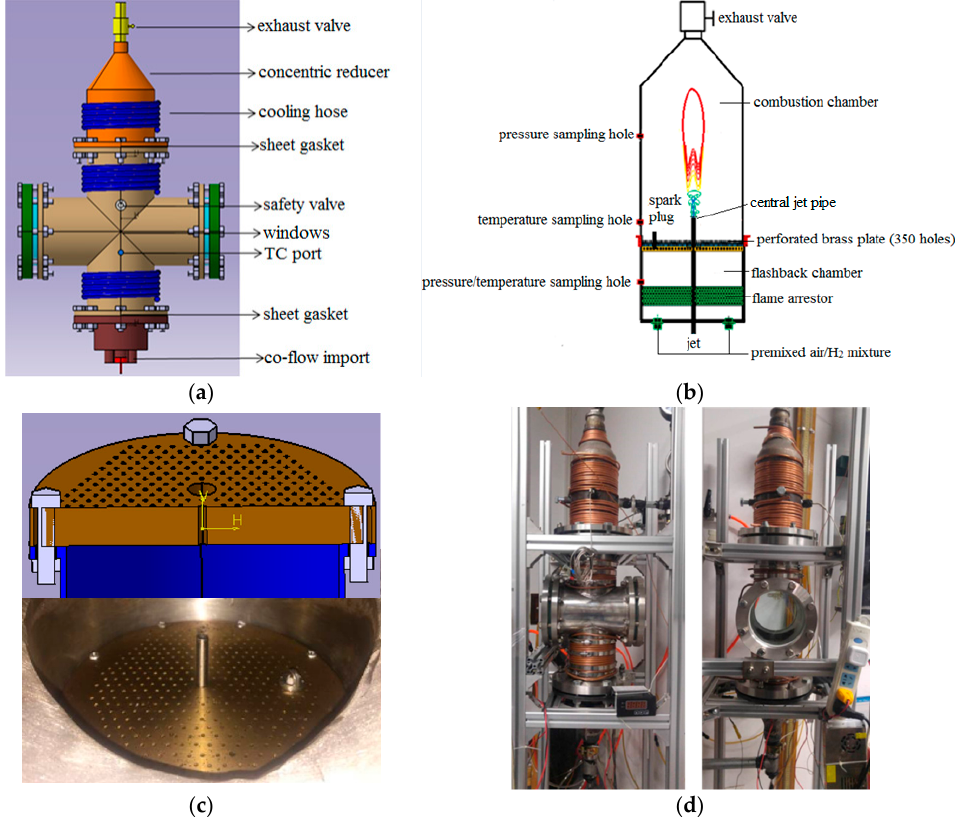
Figure 1. Schematics and photos of the pressurized vitiated co-flow burner (PVCB). ( a ) Façade; ( b ) inner structure; ( c ) perforated brass plane; ( d ) photos.